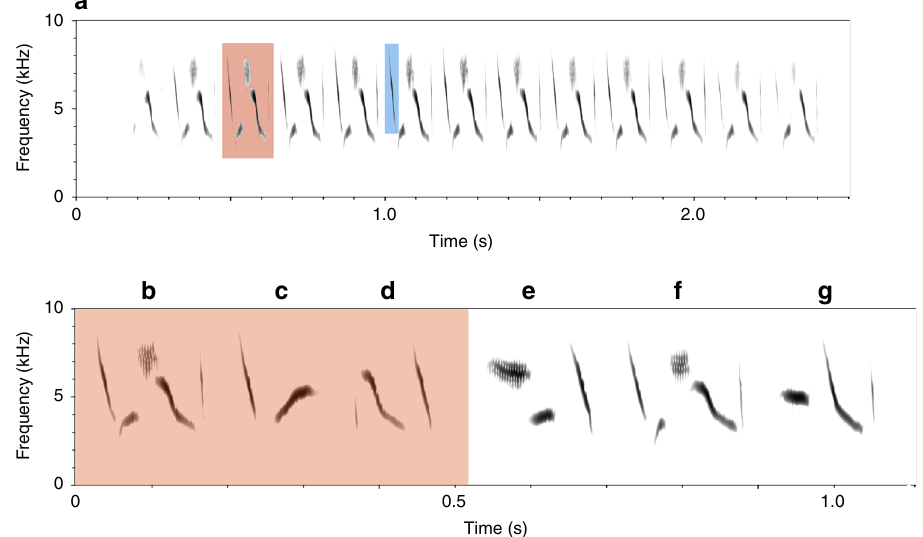
Fig. 1 Swamp sparrow song structure. a Spectrogram of a swamp sparrow song sung by an individual from the Hudson Valley population. Swamp sparrow songs consist of one syllable (red) repeated 10 or more times. Each syllable consists of 2-5 elements or notes. b – g Examples of different syllable types. b – d Show the syllables that make up the repertoire of the same individual whose song is shown in a . e – g Show three syllable types sung by other males in the population, illustrating both the considerable diversity in syllable structure found within a population, but also how, as a consequence of vocal learning, different individuals also sometimes share the same syllable-type ( b , f